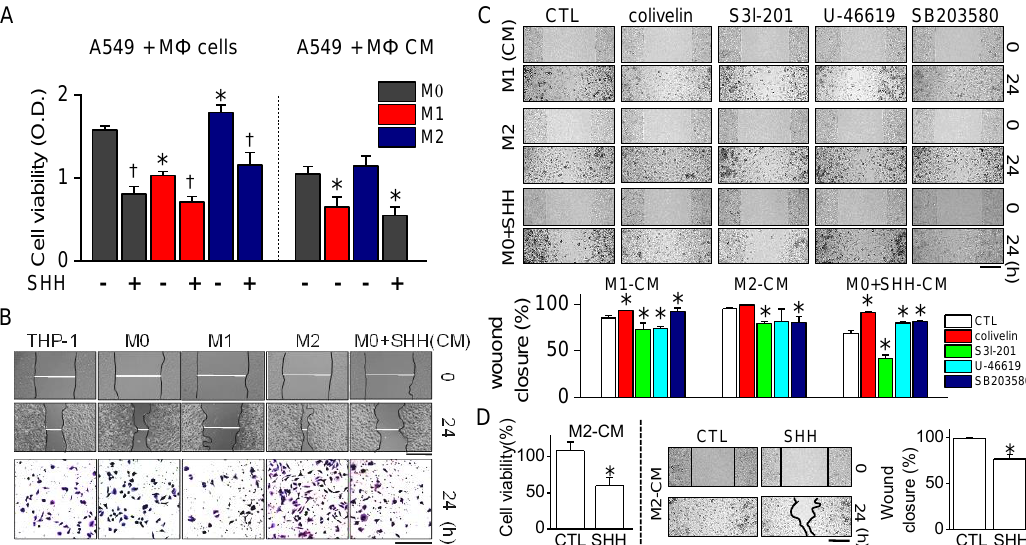
Figure 4. Proliferation and migration of A549 cells reduced by SHH treatment. ( A ) E ff ect of SHH on cell viability of A549 cells cultured with di ff erent types of macrophages or treated with molecules secreted from macrophages. Each bar is the mean ± SD obtained from eight independent experiments ( n = 8). * p < 0.05 compared to M0 co-culture. † p < 0.05 compared to each corresponding control (without SHH). ( B ) E ff ect of SHH on wound healing. Phase-contrast images of wound areas at 0 and 24 h after wounding of A549 cells. Bottom panel shows migration ability of A549 cells treated with each macrophage conditioned medium (CM). The CMs were from the culture media of THP-1, M0, M1, M2, and SHH-treated M0 cells. Migrated cells remaining on the bottom surface were stained with 0.5% methylene blue. Scale bars, 500 µ m for wound closure and 100 µ m for migration. ( C ) E ff ect of STAT3 and p38 modulators on wound healing reduced by SHH. The cells were treated with CMs from M1, M2, and SHH-treated M0 cells for 24 h. Scale bar, 100 µ m. Bar graphs show percentage of wound closure in the cells treated with the indicated chemicals. Five independent experiments were performed ( n = 5). * p < 0.05 compared to each corresponding control. ( D ) E ff ect of SHH on cell viability and wound healing increased by M2-CM. SHH were added to A549 cells for 24 h in the presence of M2-CM. Scale bar, 100 µ m. Data are shown as the mean ± SD of four independent experiments ( n = 4). * p < 0.05 compared to the